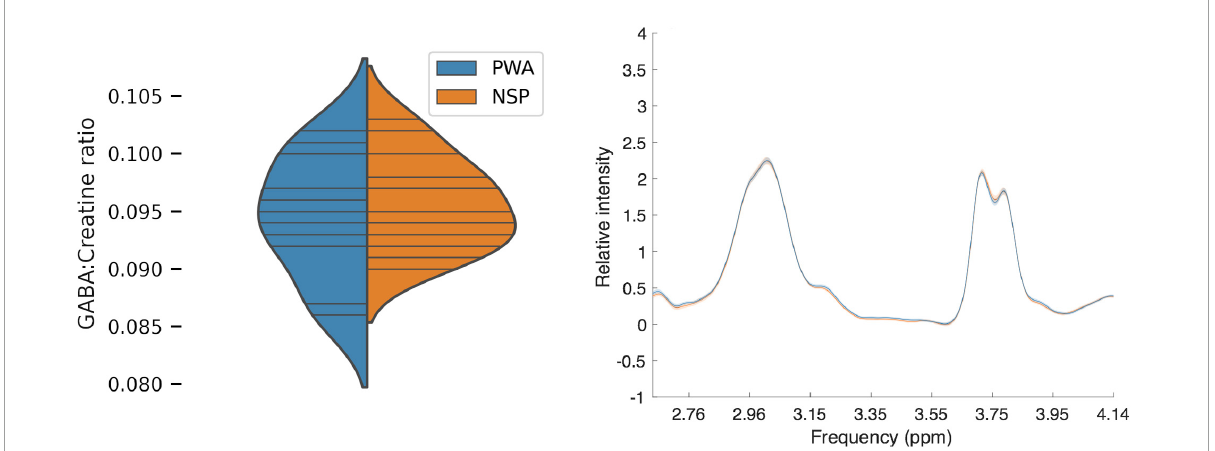
FIGURE6 Left: Plot of MRS GABA:creatine ratio values in visual cortex. Blue, persons with amblyopia ( N = 14; mean = 0.09, SEM = 0.001). Orange, normally sighted persons ( N = 15; mean = 0.09, SEM = 0.001). Horizontal lines indicate visual cortical GABA levels in individual participants, and plotted distributions are kernel density estimates. There was no significant difference in visual cortical GABA levels between the two groups. Right: Mean normalized MRS spectra for PWA (blue) and NSP (orange). Width of colored regions indicates standard error of the mean. The mean normalized spectra are very similar for the two